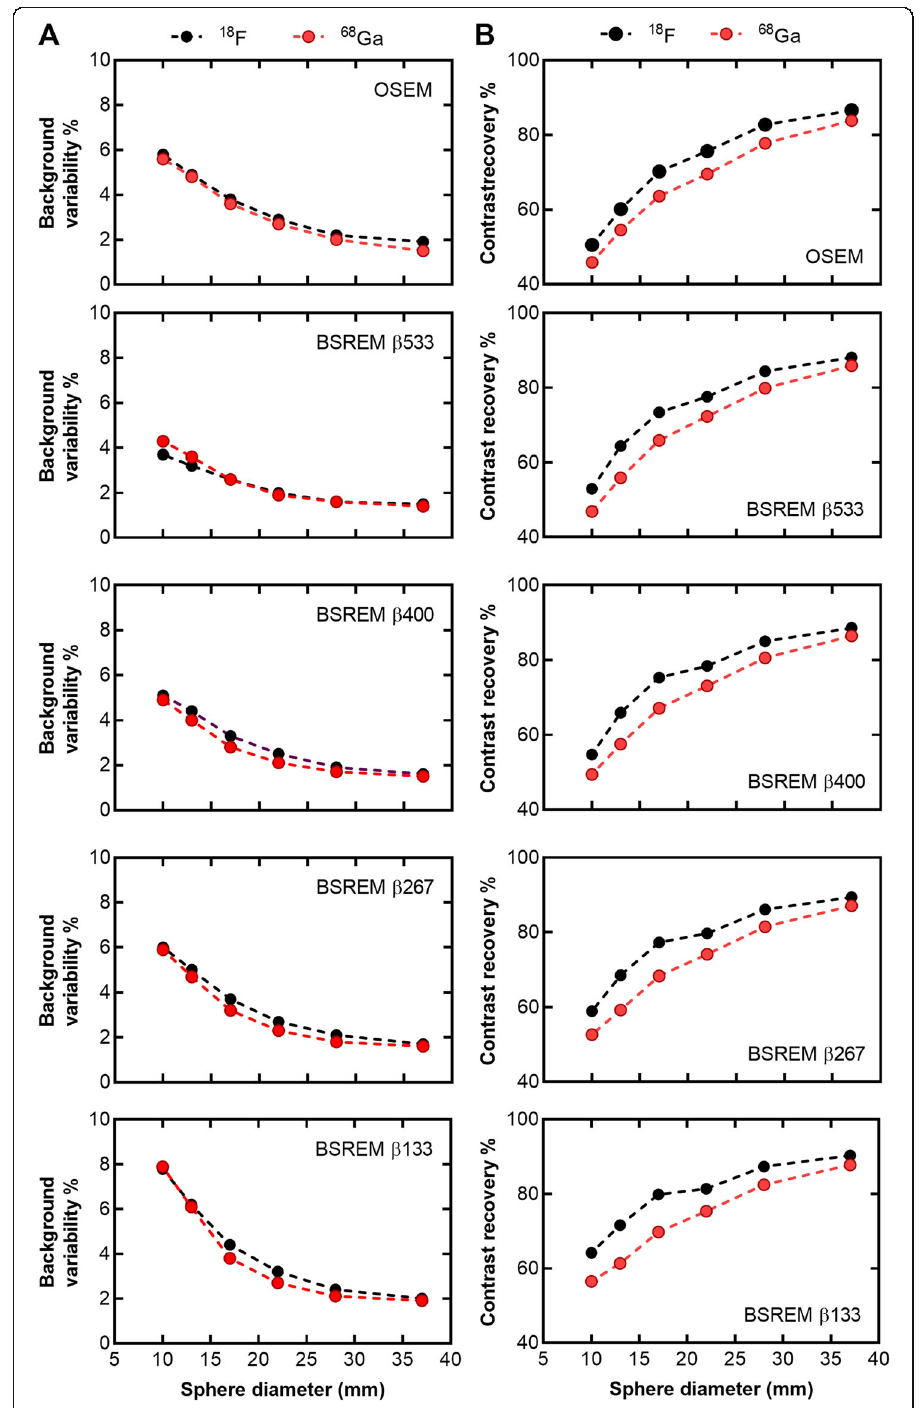
Fig. 1 Background variability % ( a ) and contrast recovery % ( b ) of NEMA image quality phantom measurements with 18 F (black) and 68 Ga (red). The five graphs in each column display the results of separate reconstruction methods; OSEM (3 iterations, 16 subsets, 5-mm Gaussian post-processing filter) and BSREM with β -values of 133, 267, 400, and 533. Both reconstruction methods included TOF and PSF